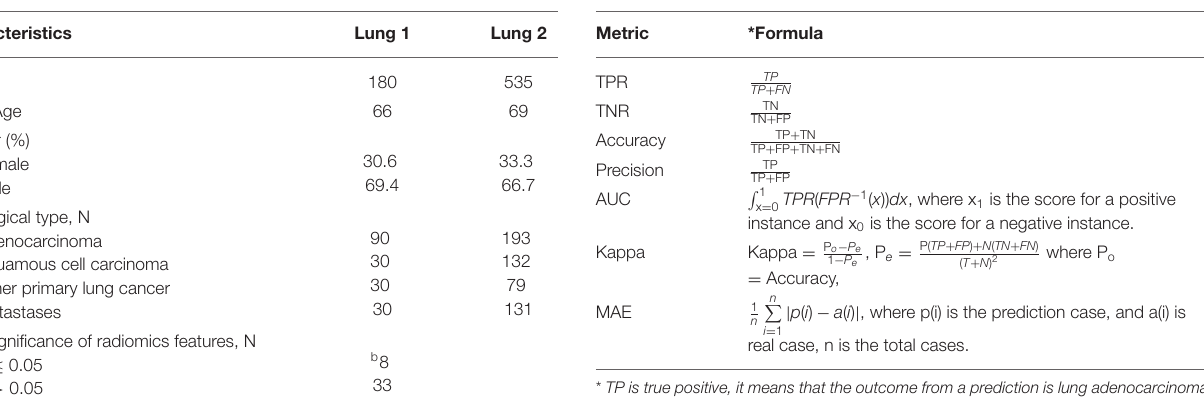
TABLE 3 | Patient characteristics. TABLE 4 | The calculation formulas of performance